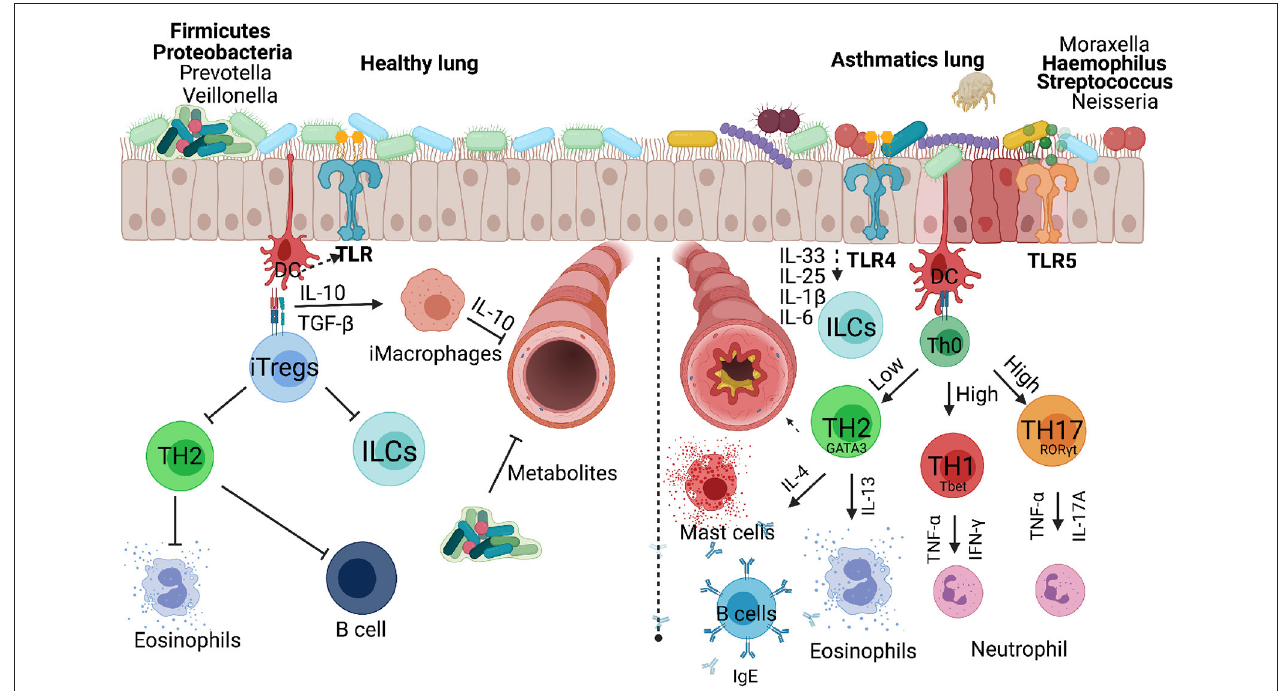
FIGURE 3 | Respiratory bacteria and microbiota that infect or reside in the upper and lower respiratory airways either inhibiting or exacerbating development of allergic asthma in children. Microbiota dominated by Firmicutes and Proteobacteria protect a developing lung promoting secretion of metabolites that can inhibit infectious microbes. Inducible regulatory cells play a key role in countering TH2, innate lymphoid cells and B cells which contribute to asthma development. Invading microbes can either counter TH2 responses or exacerbate allergic asthma through activating TLRs signals that favour TH1 or TH17 responses associated with severe form of asthma. Created with